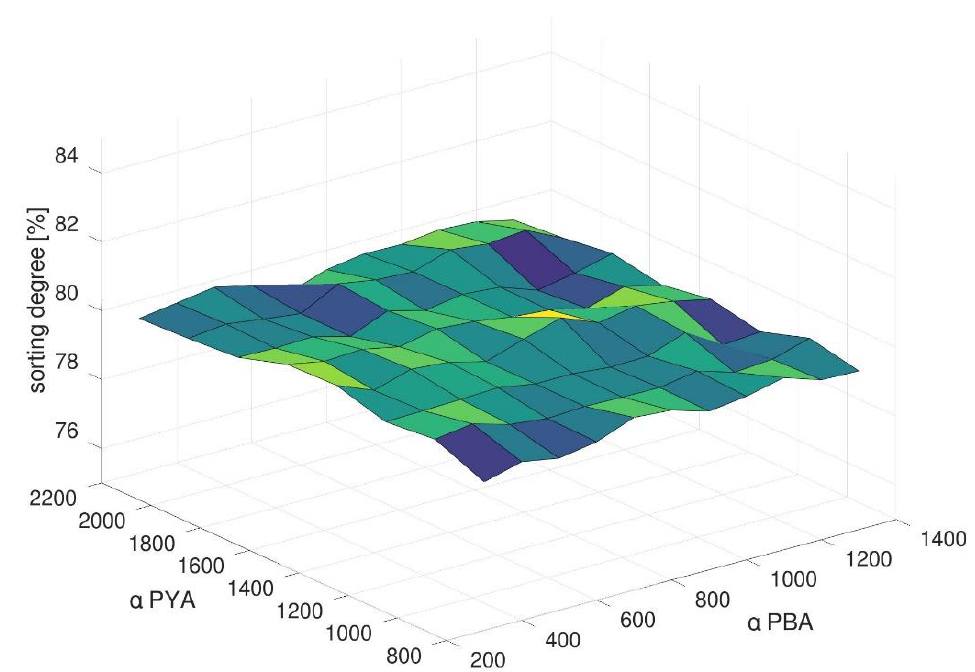
Figure 7. Impact of evaporation constants on sorting degree.